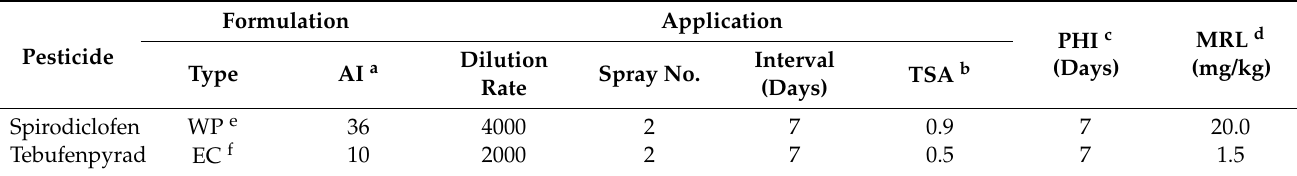
Table 1. The formulation of spirodiclofen and tebufenpyrad investigated in the present study.